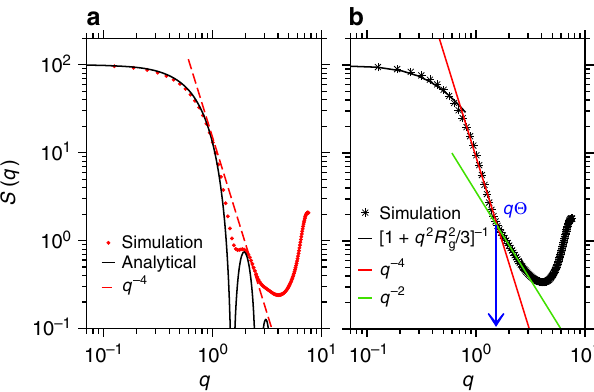
Fig. 3 Single-chain structure factor. Static structure factor S ( q ) for a chain of length N l = 100. a S ( q ) at x c = 0.0 and ( b ) x c = 0.7. In a , we also include the analytical expression for sphere scattering. In b , red and green lines are power law fi ts to the data at different length scales. The black line represents the Guiner region for q → 0 (for large length scales). The vertical arrow indicates the effective Θ — blob size at q = q Θ , estimated using ‘ Θ (cid:3) ¼ 2 π = q Θ . Note: to get a better estimate of the cross-over scaling blob regime, S ( q ) is calculated from a simulation of a chain length N l =